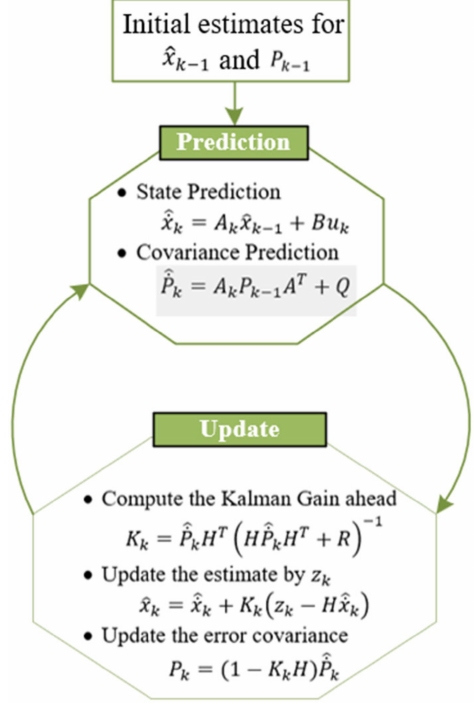
Figure 3. The operation procedure of KF.